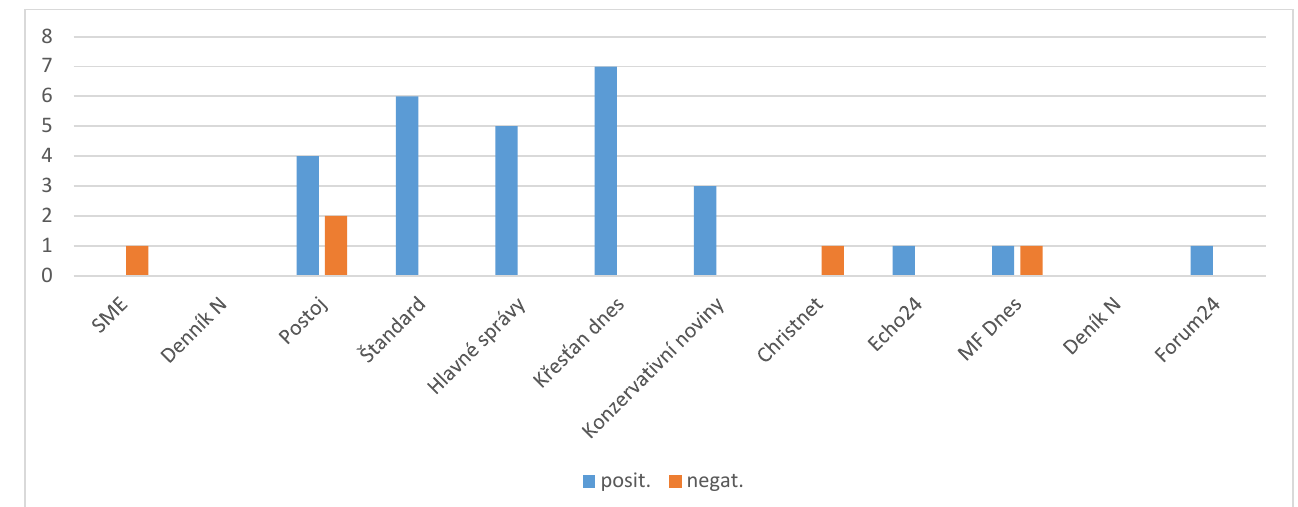
Figure 9. Occurrences of ‘religious freedom’ as an argument (A6).